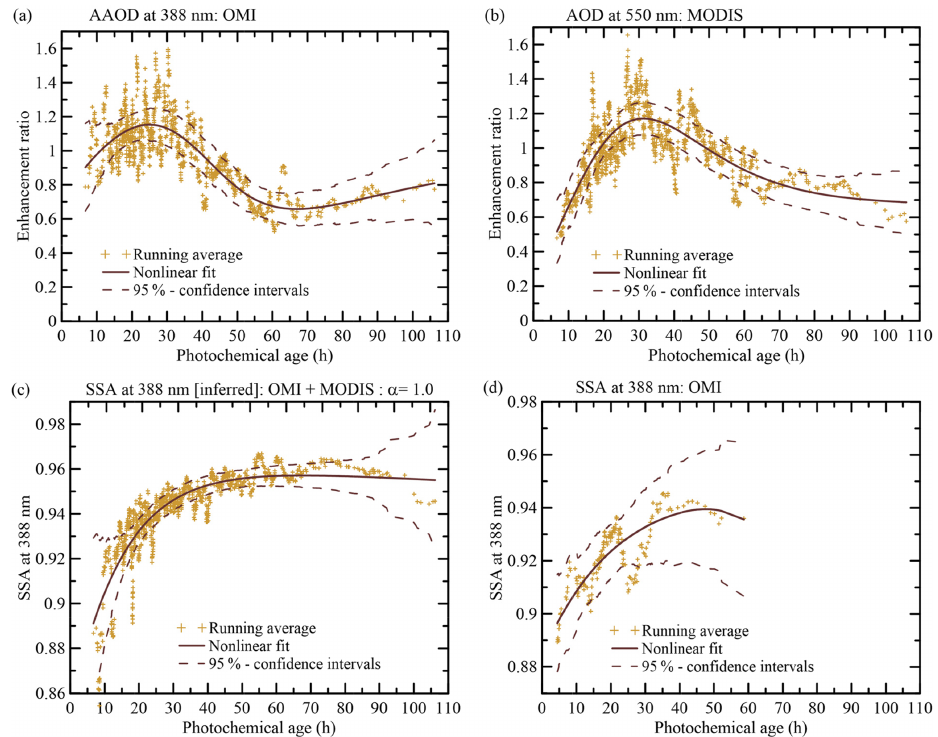
Figure 5. Nonlinear approximations (see Eq. 5) of the dependencies of (a, b) EnRs for AAOD (388nm), AOD (550nm), and (c, d) SSA (388nm) on the photochemical age of BB aerosol. Also shown are the running averages over every 15 consecutive data points (for EnRs or SSA) arranged with respect to the photochemical age and the 95% confidence intervals for the approximations. The SSA values approximated in panel (c) are inferred from the OMI AAOD and MODIS AOD observations, while those presented in panel (d) are provided directly in the OMAERUV data product.